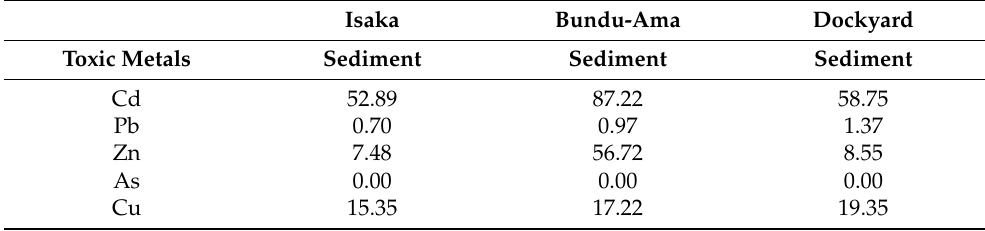
Table 6. Enrichment factor for toxic metals in the Isaka–Bundu tidal mangrove swamp.